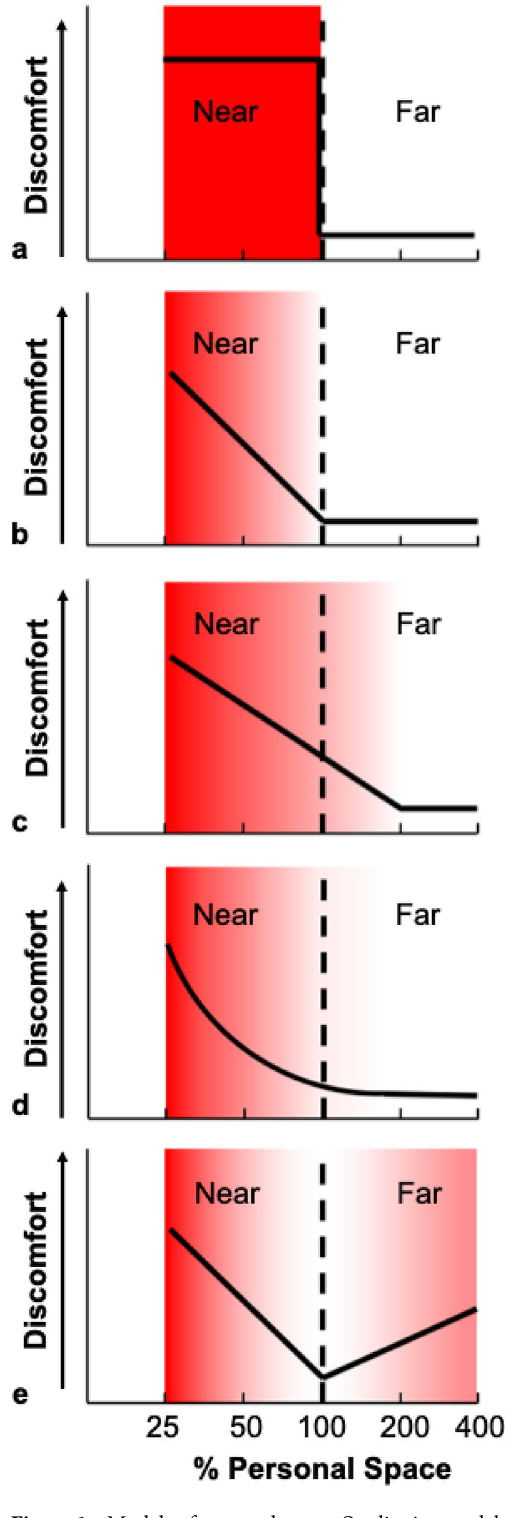
Figure 1. Models of personal space. Qualitative models of variations in discomfort (on the y axis) to an unfamiliar human positioned at different distances from a subject, as a percentage of the subjects’ personal space size (x axis). The dashed vertical line represents the personal space boundary, i.e. 100% of the average SDP value for each subject. The models include a: ( a ) bubble model, ( b ) linear gradient model, ( c ) linear gradient with a threshold, ( d ) power law, and ( e ) social equilibrium model. The panels also show the hypothesized changes in discomfort for each model, as variations in red shading (most discomfort = most saturated